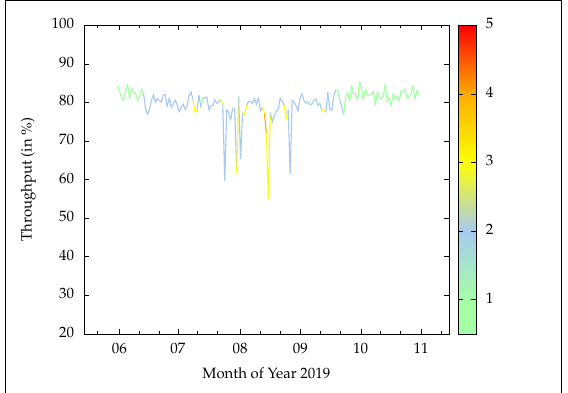
Figure 12. The achieved throughput in percent, per day during the firefighting season of